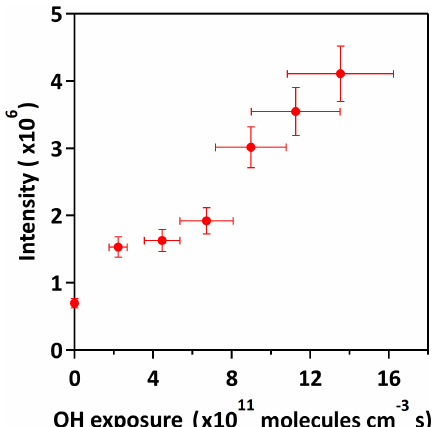
Figure 2. The evolution of the ion intensity of bisulfate ion (HSO − as a function of OH exposure during the heterogeneous OH oxida- tion of potassium 3-methyltetrol sulfate ester at 70.8%RH.